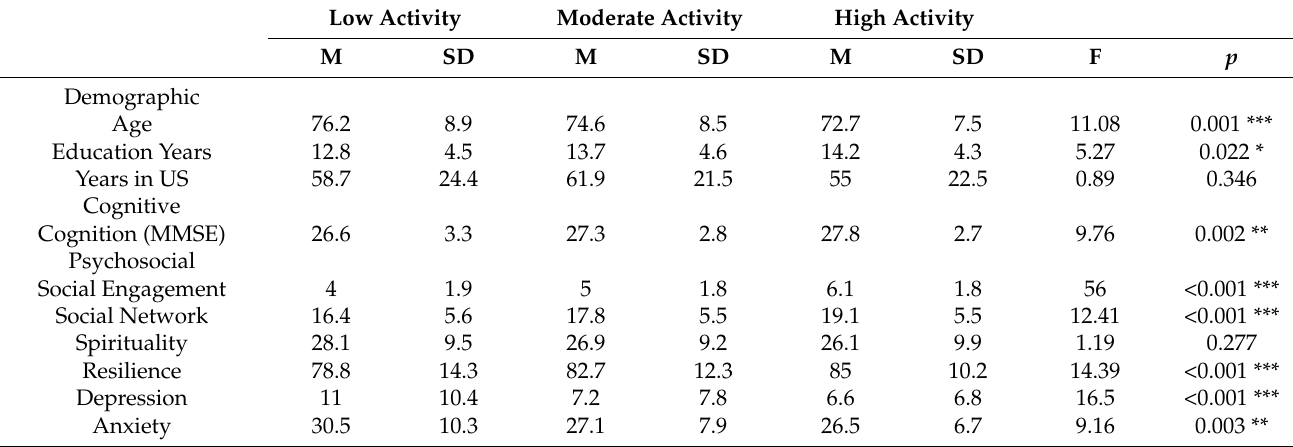
Table 3. Differences by Physical Activity